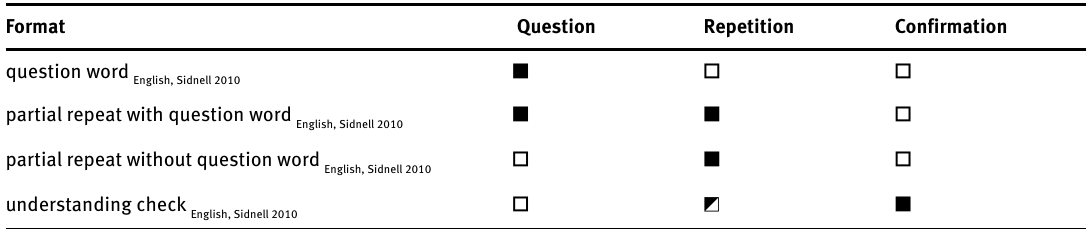
Table 5: Three properties of restricted repair initiators and four formats for repair initiation, showing the relation between the distribution of properties and format